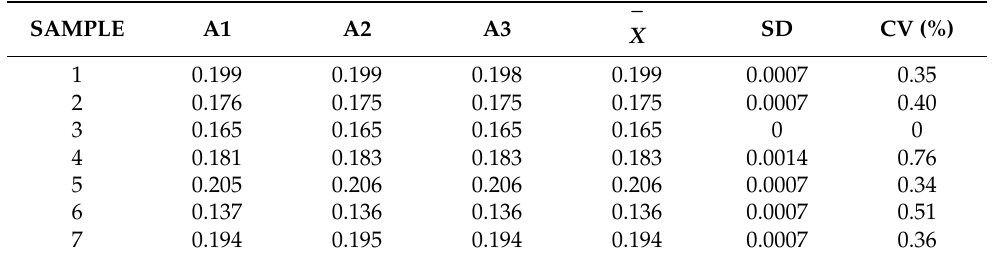
Table 10. Absorbances obtained for lypophilic extracts of cream samples (FRAP method).